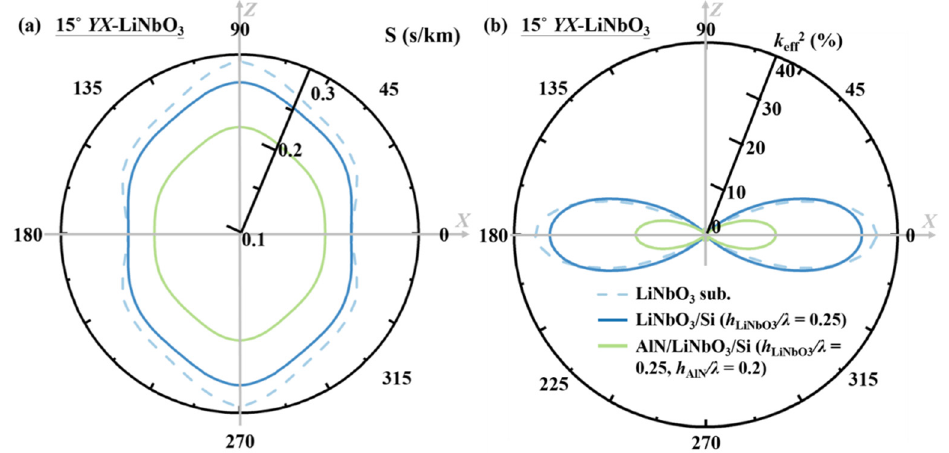
Figure 11. Calculated ( a ) slowness curve; ( b ) effective coupling coefficient k eff2 of the SH wave versus different propagation direction on the 15° YX -LiNbO 3 substrate, LiNbO 3 /Si ( h LiNbO3 / λ = 0.25), and AlN/ LiNbO 3 /Si ( h LiNbO3 / λ = 0.25, h AlN / λ = 0.2) .